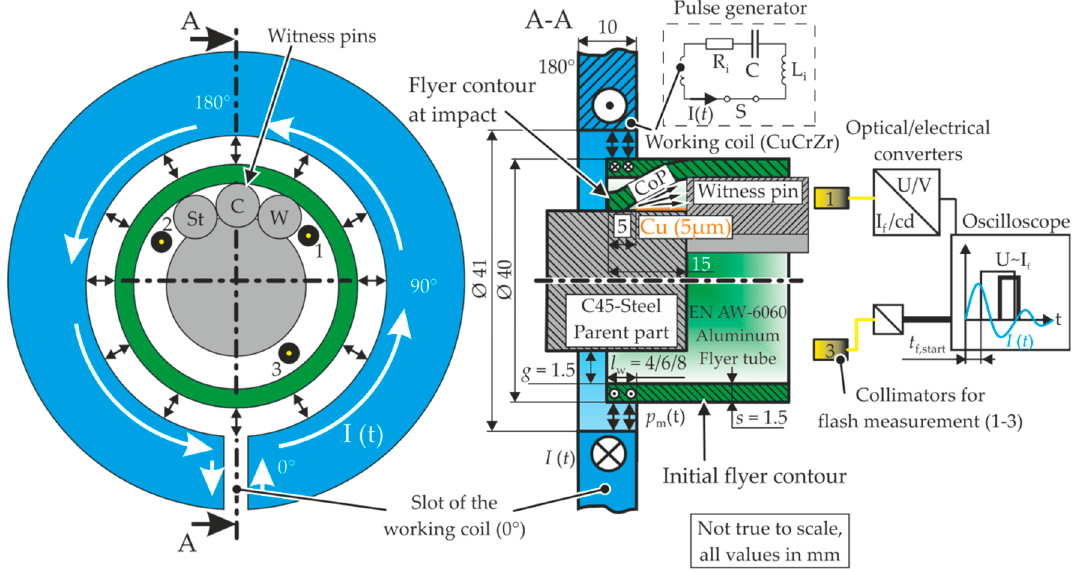
Figure 5. Setup for flash detection, analysis of the CoP composition and properties in the MPW tube welding setup.